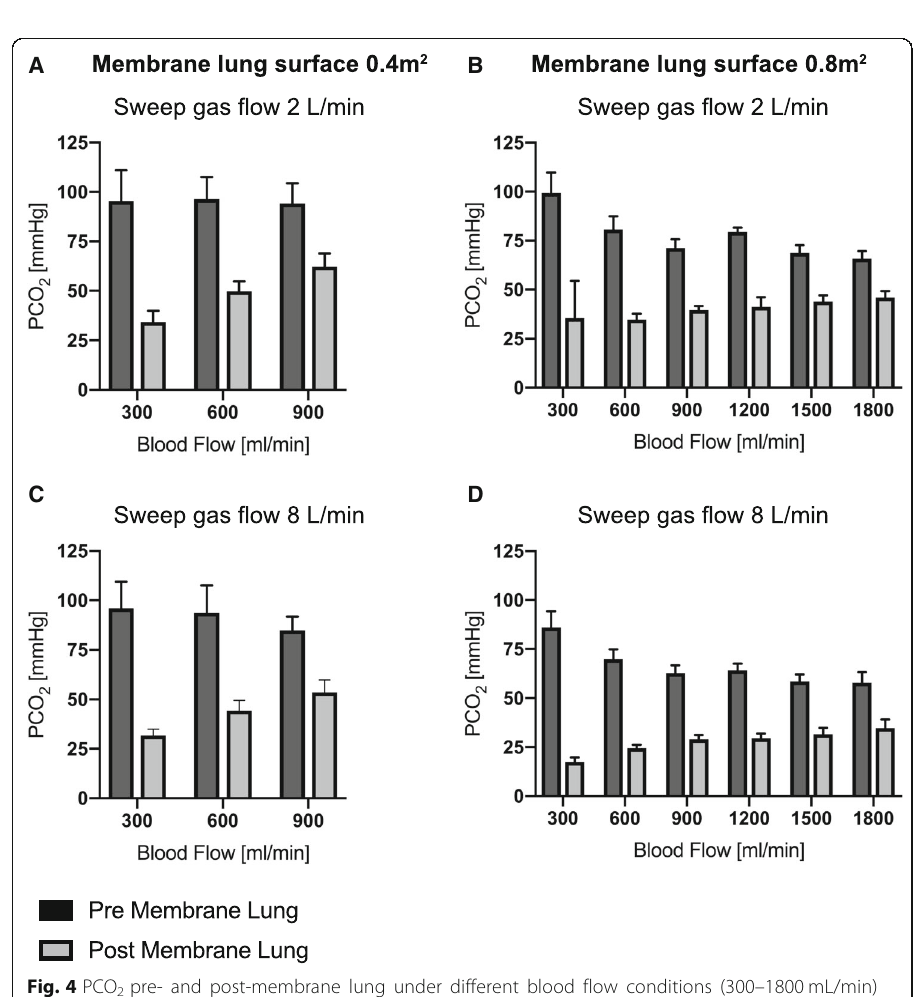
Fig. 4 PCO 2 pre- and post-membrane lung under different blood flow conditions (300 – 1800 mL/min) with two different membrane lung surface areas (0.4m 2 ( a and c ) and 0.8m 2 ( b and d )). Each data point represents the mean and standard deviation among nine